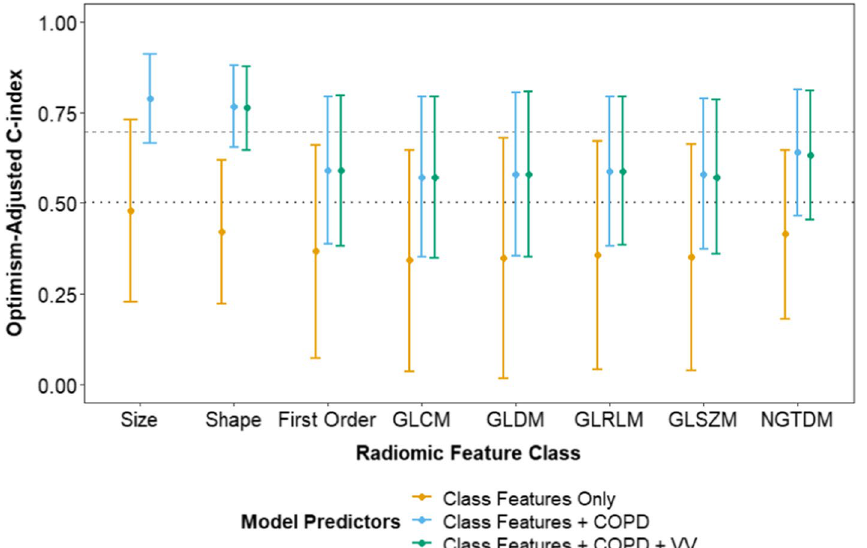
Fig. 2 Performance of LASSO-Cox multivariable models for pneumonitis prediction based on lung radiomic features only (orange) or in con- junction with chronic obstructive pulmonary disease (COPD) (blue) or COPD and voxel volume (VV) (green) as added features. Each class of radiomic features was considered separately. The horizontal dotted line indicates the null value (c-index = 0.5) and the horizontal dashed line indicates the benchmark COPD-only model (c-index = 0.69). GLCM = gray-level co-occurance matrix; GLDM = gray-level dependence matrix; GLRLM = gray-level run-length matrix; GLSZM = gray-level size zone matrix; NGTDM = neighboring gray-tone difference matrix Fig. 3 Performance of LASSO- logistic multivariable models for chronic obstructive pulmonary disease (COPD) prediction based on lung radi- omic features only (orange) or in conjunction with voxel volume (VV) (blue) as an added feature. GLCM = gray- level co-occurance matrix; GLDM = gray-level depend- ence matrix; GLRLM = gray- level run-length matrix; GLSZM = gray-level size zone matrix; NGTDM = neighboring gray-tone difference